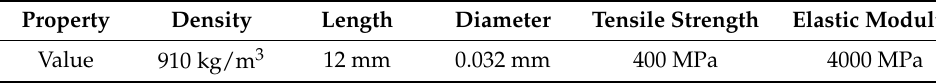
Table 4. Properties of polypropylene